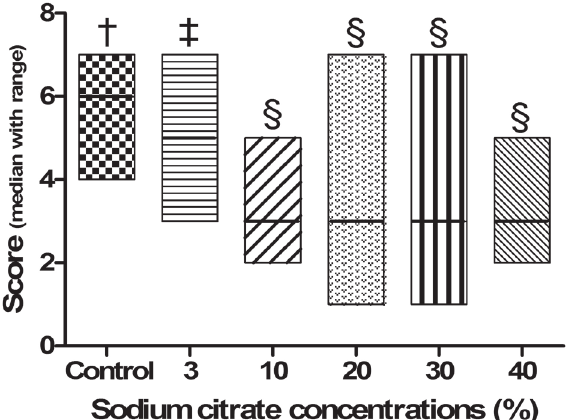
Figure 4- Median with range of the scores obtained for the three application methods of the citric acid. Application methods with the same symbol are not statistically different